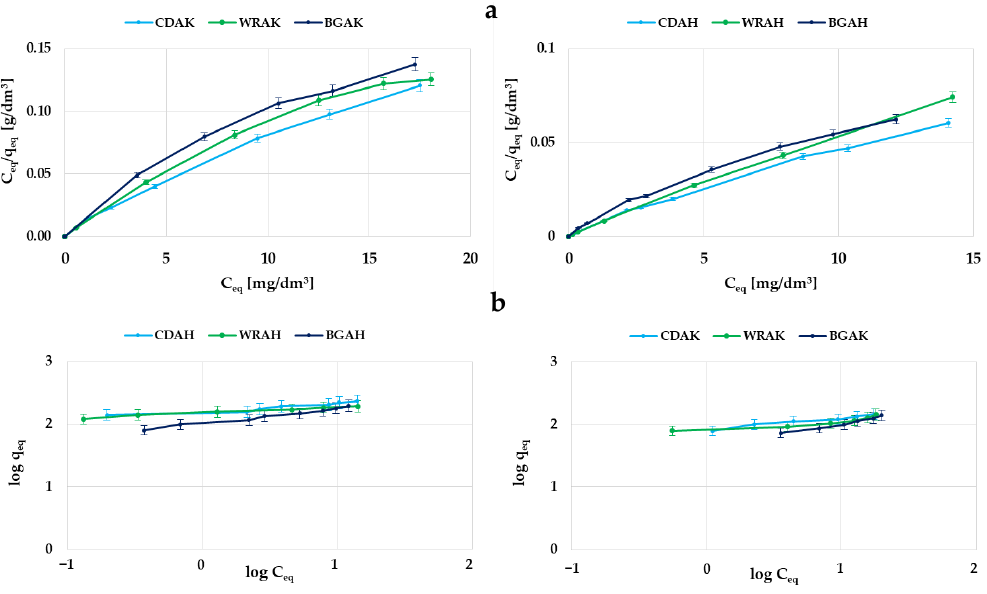
Figure 8. Adsorption of methylene blue on the samples activated with H 3 PO 4 and K 2 CO 3 : the Langmuir isotherm plots ( a ); the Freundlich isotherm plots ( b ).